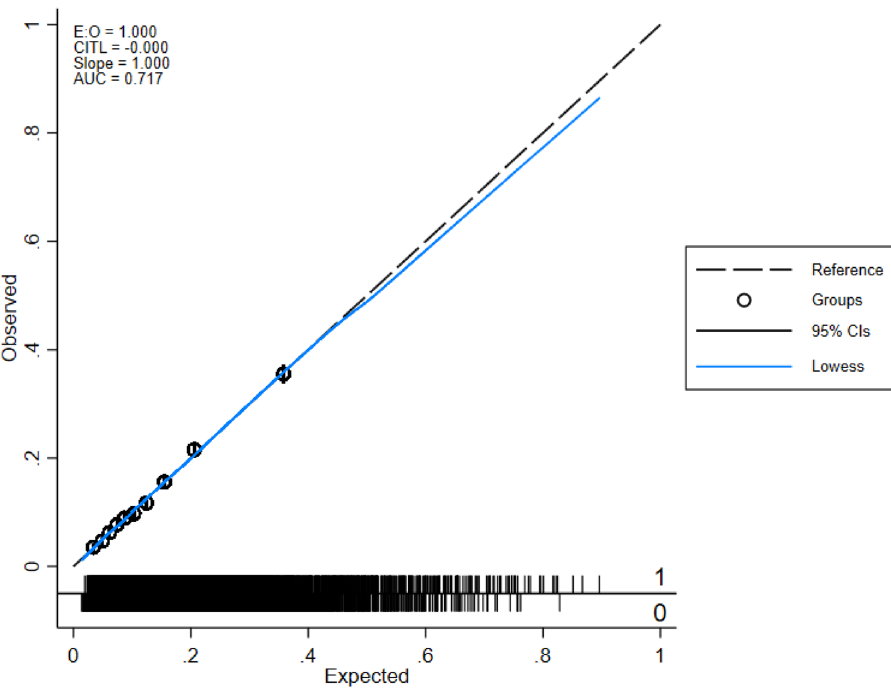
Figure 3. Calibration plot of observed versus expected probabilities for assessment of the predictive performance of the mionl-MEWS model in the development cohort.